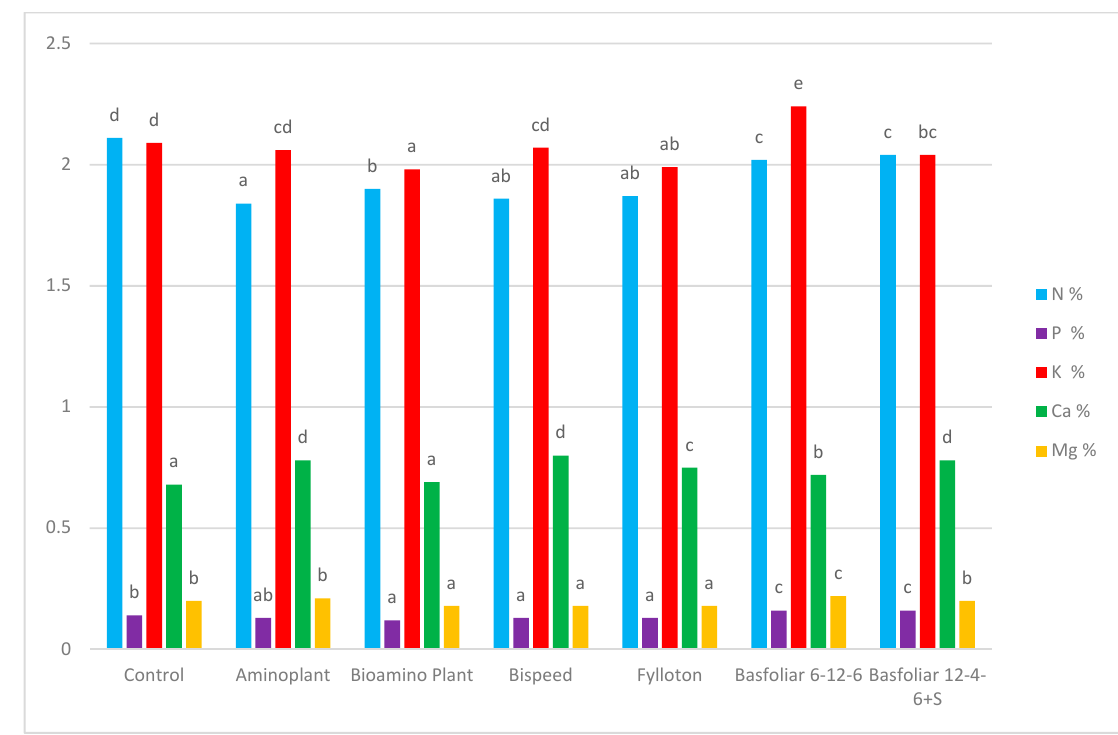
Figure 1. A comparison of the contents of macronutrients in the leaves of maiden apple trees depending on the applied foliar treatment. Data followed by the same letters do not differ significantly at p = 0.05 for each macronutrient according to Tukey’s test.